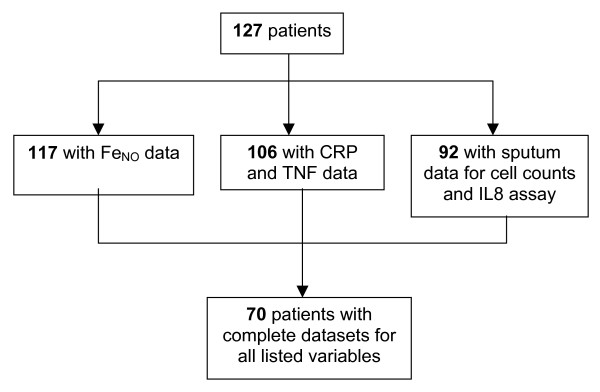
Flow chart showing the total number of patients who were able to perform all measurements and those who were unable to complete certain measurements.